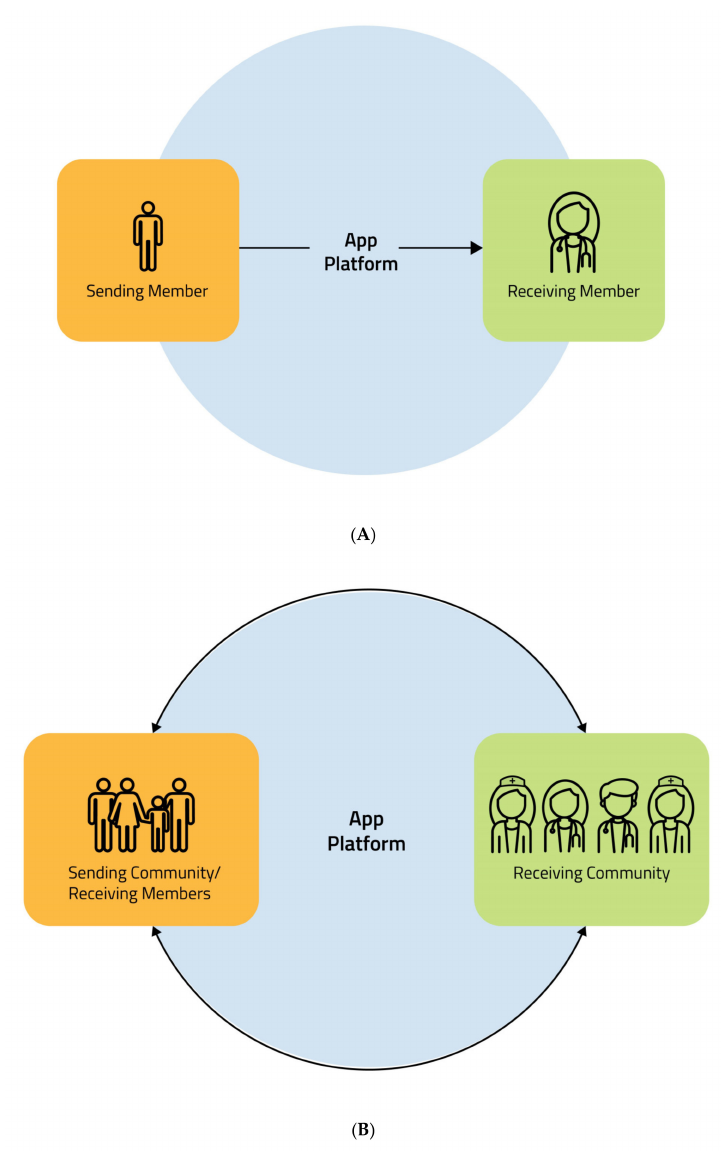
Figure 2. ( A ) Data sharing. The patient, identified as “sending member”, shares its own glucose profile data with the healthcare professionals, identified as the “receiving member”. ( B ) Data sharing: circular flow. The patient supported on the management of the diabetes by family members, cohabitants and caregivers, that we identify as “sending community”, shares glucose profile data with the multidisciplinary diabetes team, that we identify as “receiving community”, according to a model that we propose to call “circular flow”. The members of the sending community can be themselves receiving